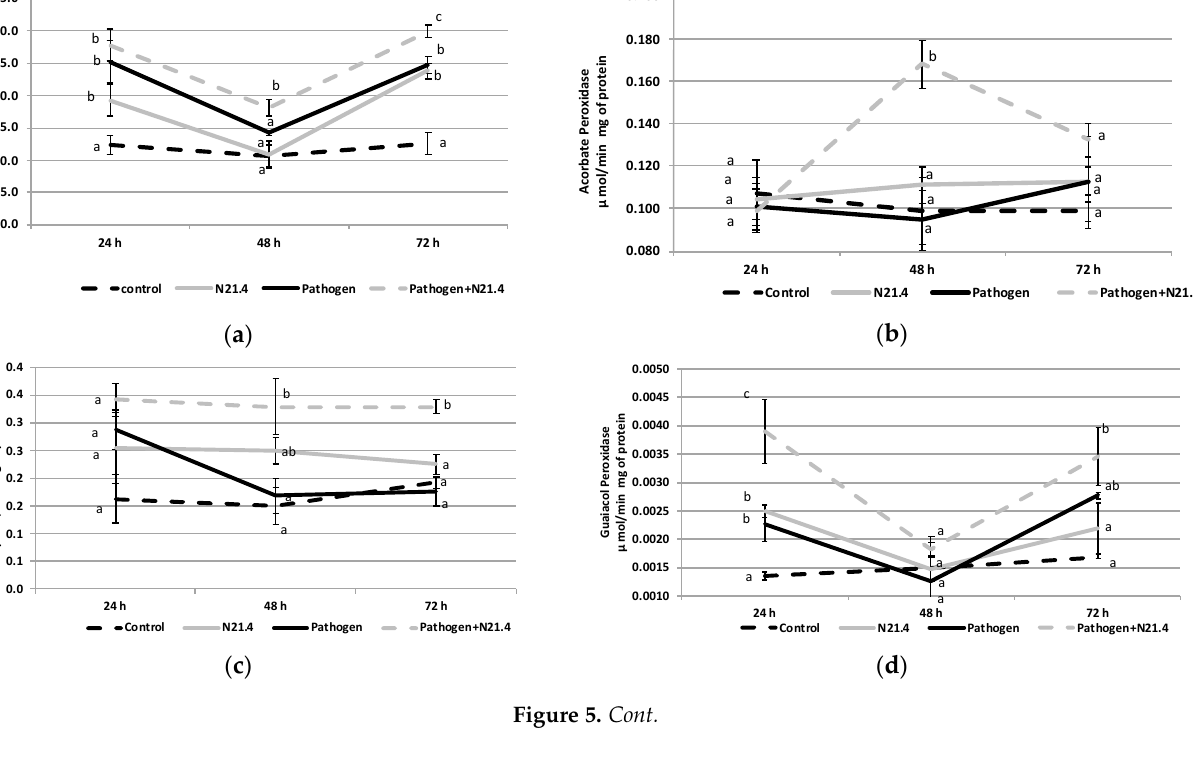
Figure 4. Total chlorophylls (mg of chlorophyll a + chlorophyll b per gram of fresh weight) in 6-week old tomato plants inoculated with P. fluorescens N21.4 and non-inoculated controls in the priming phase and in the post-challenged priming state after inoculation with the leaf spot pathogen Xanthomonas campestris . Control: Non treated or challenged plants. N21.4: plants treated with Pseudomonas fluorescens. Pathogen: plants challenged with the leaf spot pathogen Xanthomonas campestris . Pathogen + N21.4: plants treated with Pseudomonas fluorescens N21.4 and challenged with the leaf spot pathogen Xanthomonas campestris. Bars indicate standard errors ( n = 3). Different letters denote significant differences ( p < 0.05).